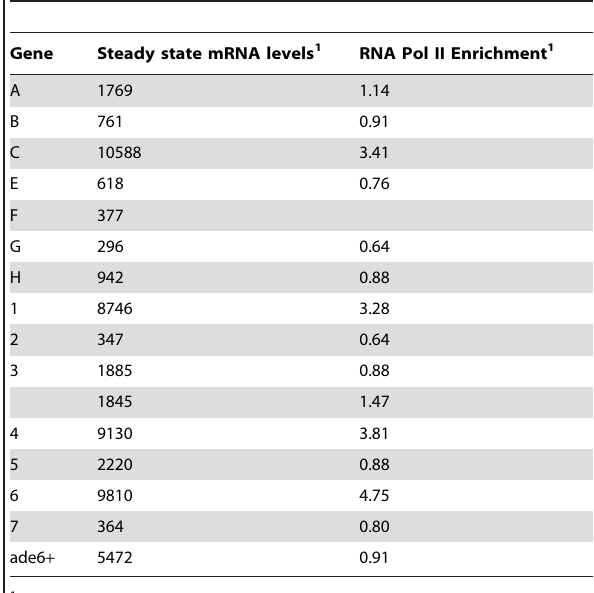
Table 2. Genes within the de novo heterochromatin domains are highly expressed and enriched in Pol